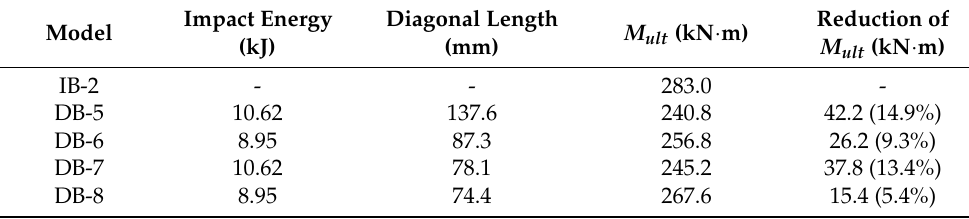
Table 12. The results of the longitudinal-bending tests: fracture damage.